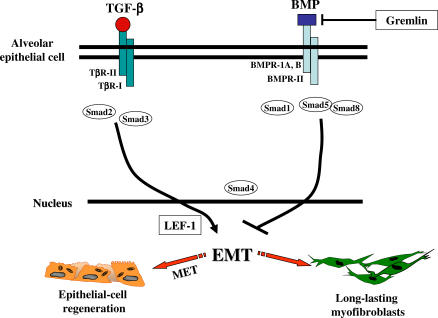
Schematic Overview of the Epithelial–Mesenchymal Transition as Modulated by TGF-β and BMPsIn IPF lungs, TGF-β3, gremlin, and LEF-1 are up-regulated, while BMP-2 is down-regulated. Dysregulation of TGF-β/BMP pathway induces a fibrotic phenotype. EMT, so important in development, is likely to represent one possible response of the alveolar epithelial cell facing sustained injury. Increased expression of BMPs may not only antagonize TGF-β-induced EMT, enhancing re-epithelialization, but also may cause the opposite process, mesenchymal-to-epithelial transition (MET).